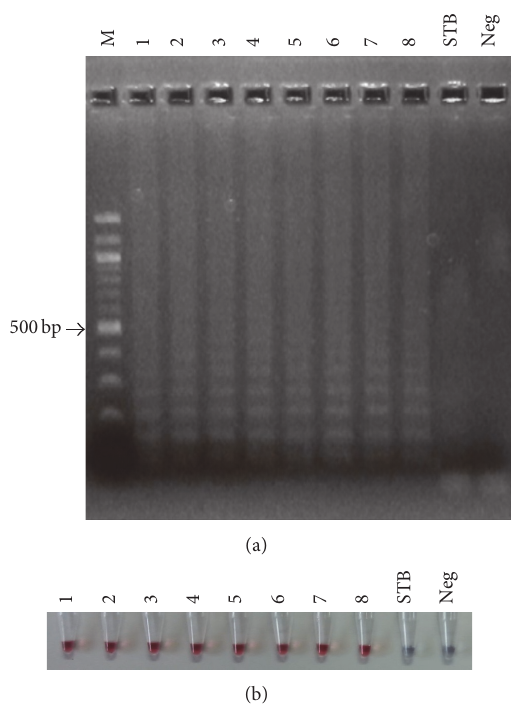
Figure 8: Au-nanoprobe colorimetric assay for MDR-TB detection. (a) Agarose gel showed LAMP products. Lane M: Ladder DNA marker; Lanes 9–16: Mut (MDR-TB), Lane STB: standard strain H37RV, and Lane Neg: negative. (b) Corresponding results recorded visually after salt challenge. Red colour showed the presence of the target, while purple indicated its absence.